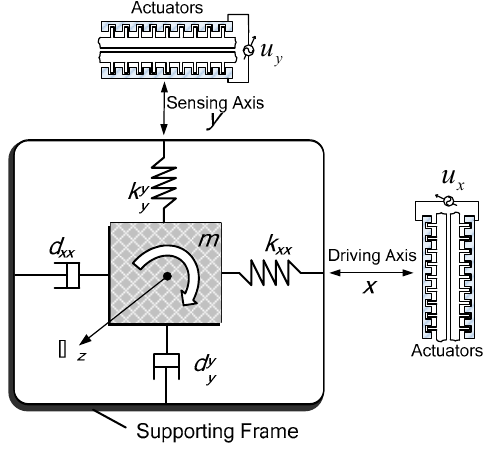
Figure 1. Schematic diagram of a micro gyroscope.